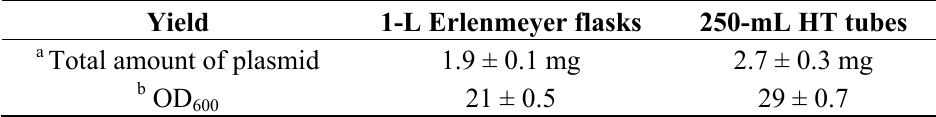
Table 1. Plasmid DNA production in E. coli.